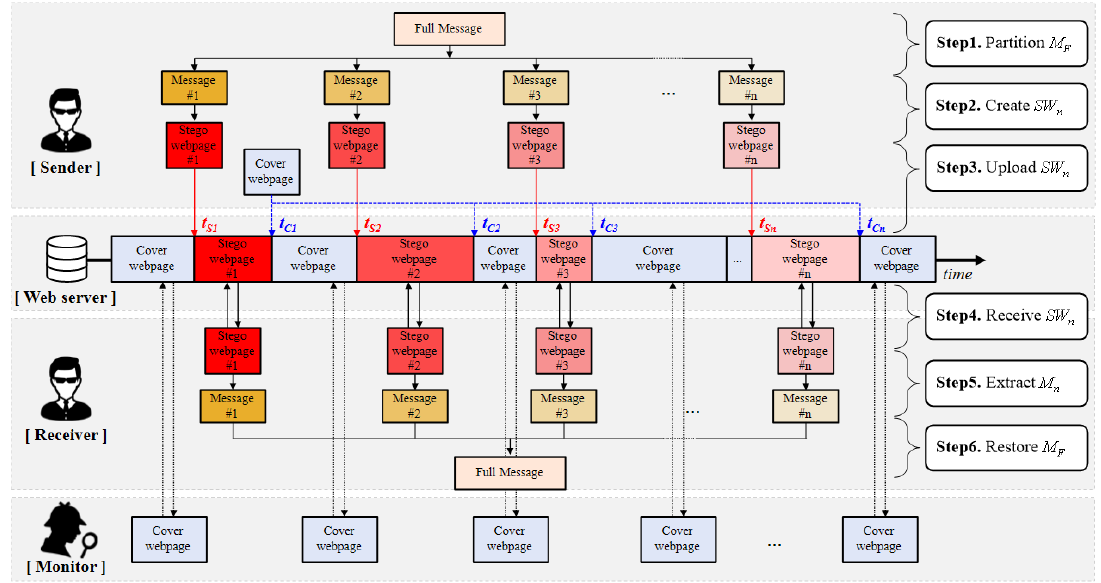
Figure 9. A hybrid approach that combines TDOA-C and TDOA-U.